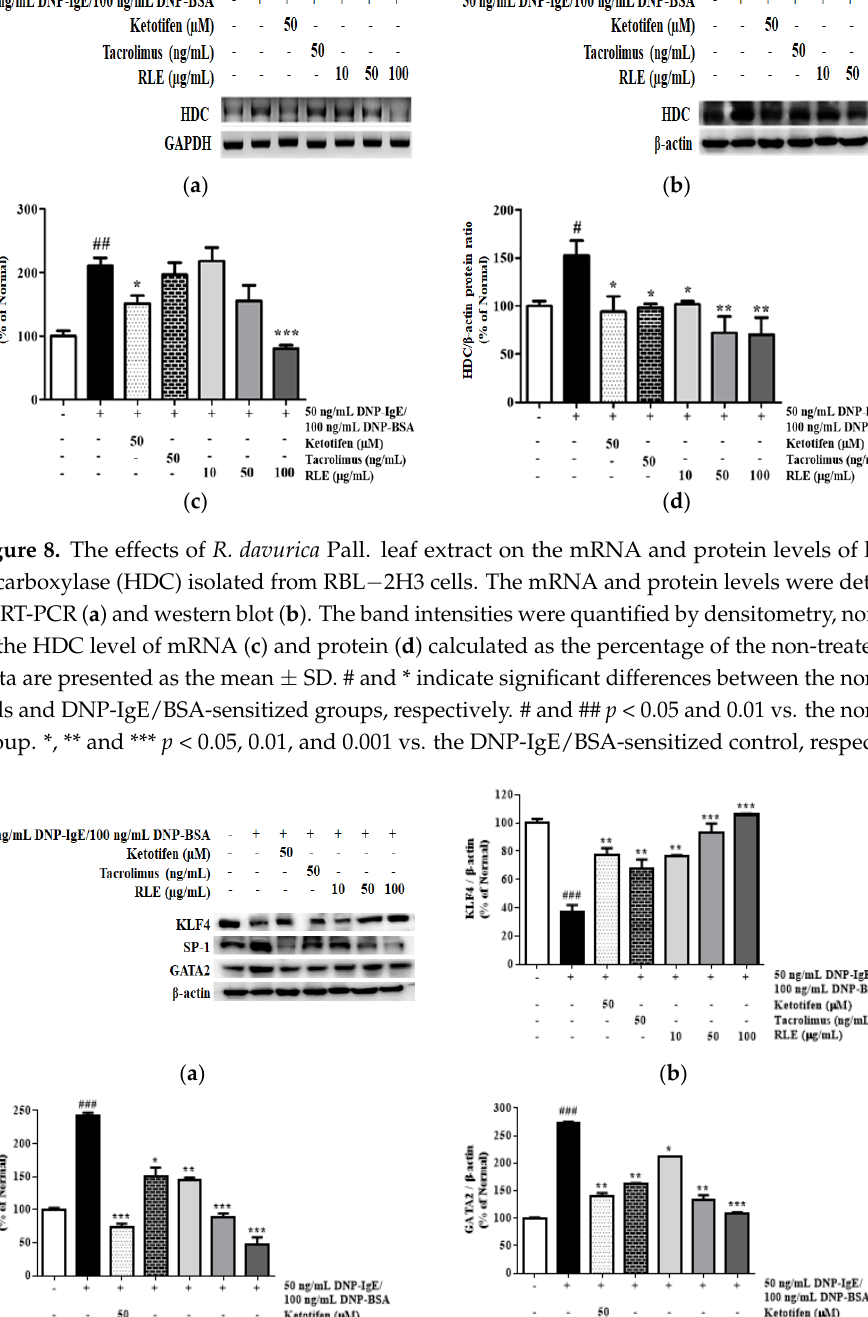
and 36.1%, respectively, whereas RLE restored KLF4 protein levels by 43.3%, compared to the DNP ‐ IgE/BSA control group.